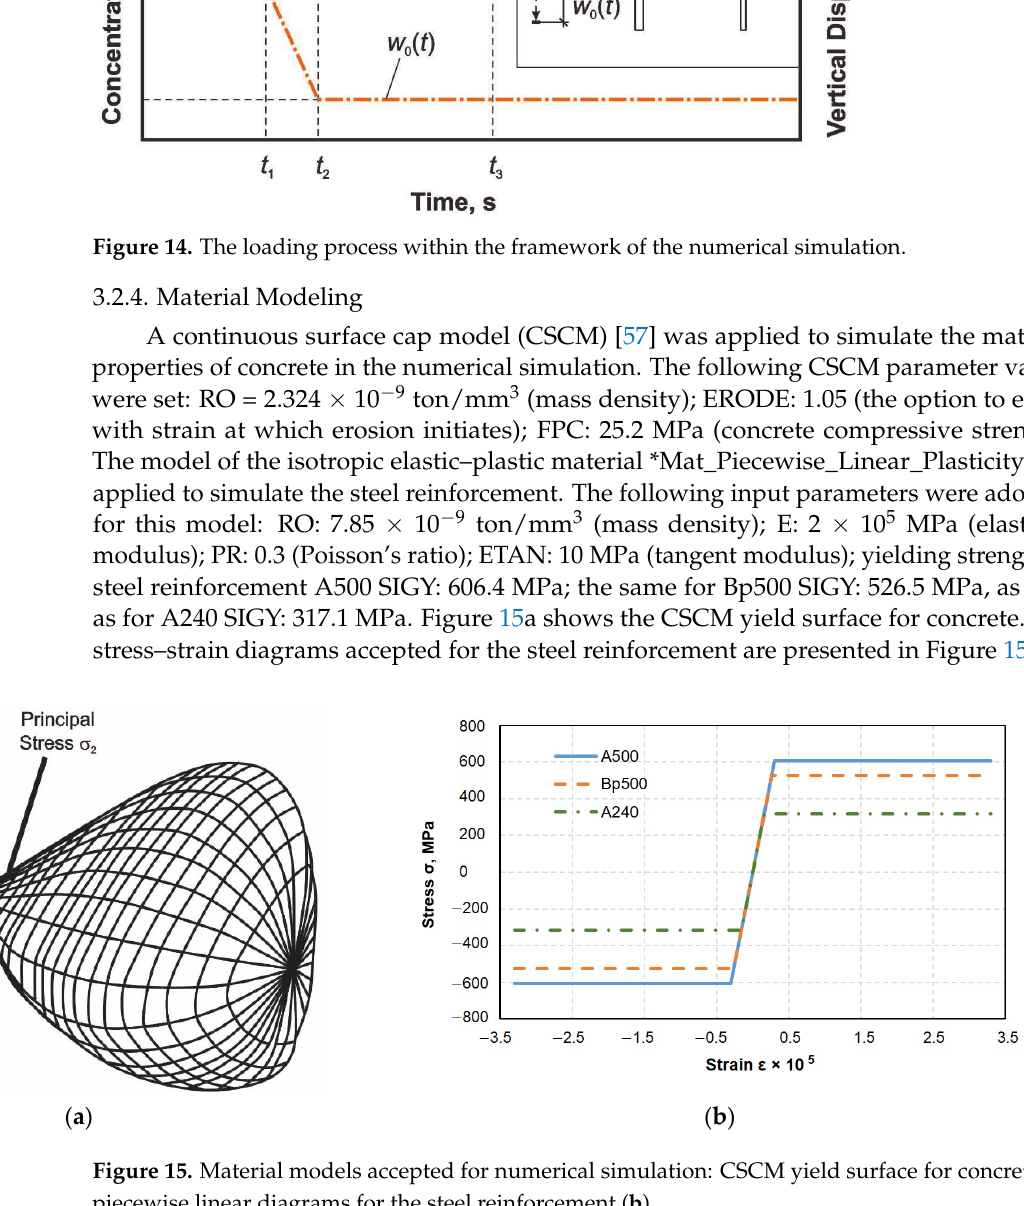
( b ) Figure 16. The history of displacements for structural joint D in the direction of the Z axis ( a ) and a section in the middle part of column 2 in the direction of the X axis ( b ). The numerical curve of the history of vertical displacement of joint D reproduces the experimental curve up to time point 0.4 s after the accidental impact on the frame (corner column removal). Starting from 0.4 s, there was a discrepancy between the simulation and the experiment data, which reached 34%. The discrepancy (Figure 16b) is due to the influ- ence of (1) natural vibrations of the loading device on experimental results and (2) crack- ing of the experimental frame before the collapse of column 2. However, experimental and numerical results remain close with respect to the maximum values of column dis- placements before the collapse. The simulated X displacement of the middle part of col- umn 2 at the moment of destruction practically coincided with the experimental data, with values of 8.64 and 8.43 mm, respectively. The damage patterns, as well as the deformed state of the frame (Figure 17), simu- lated in Ls-dyna almost coincide with the test data presented in Figure 11. Large openings